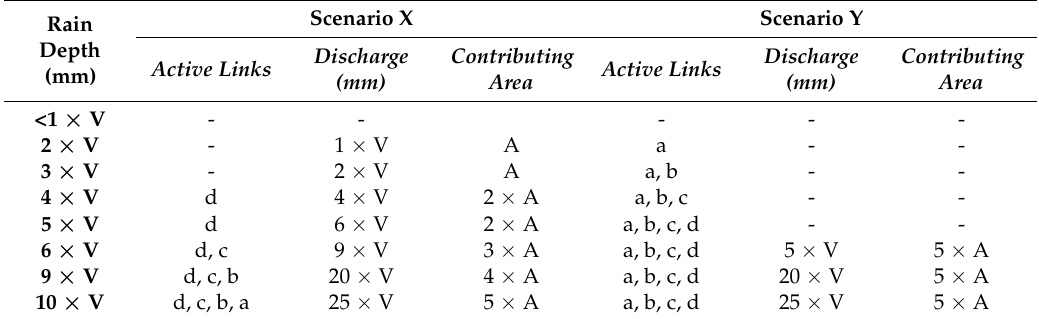
Table 3. Response matrix of the conceptual model in the case of scenarios X and Y (see Figure